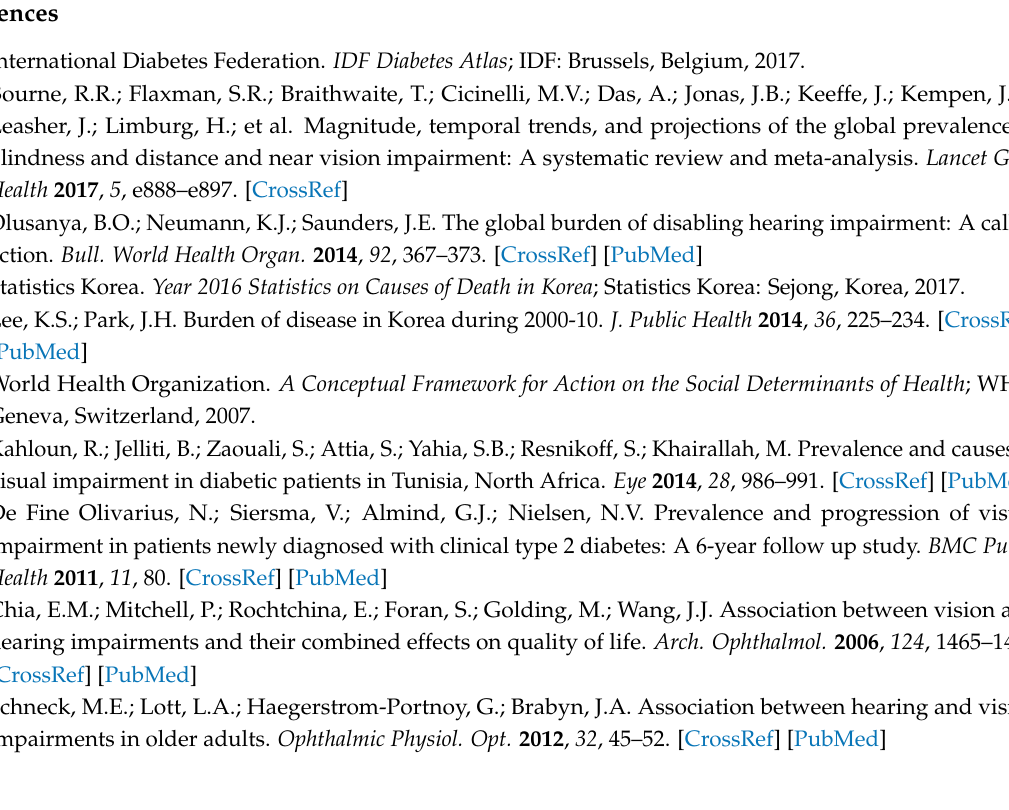
Table S1. The multinomial logistic regression results: the odds ratio for variable/association. Figure S1. The receiver-operating-characteristic curve from the Artificial Neural Network. Author Contributions: Conceptualization, K.-S.L. and K.W.P.; data curation, K.-S.L. and K.W.P.; formal